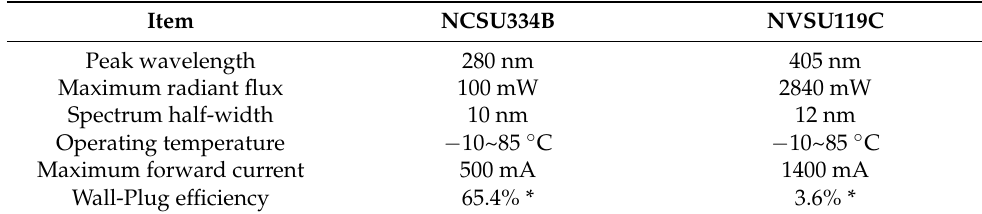
Table 1. Specifications of LED (obtained from Nichia Corporation).